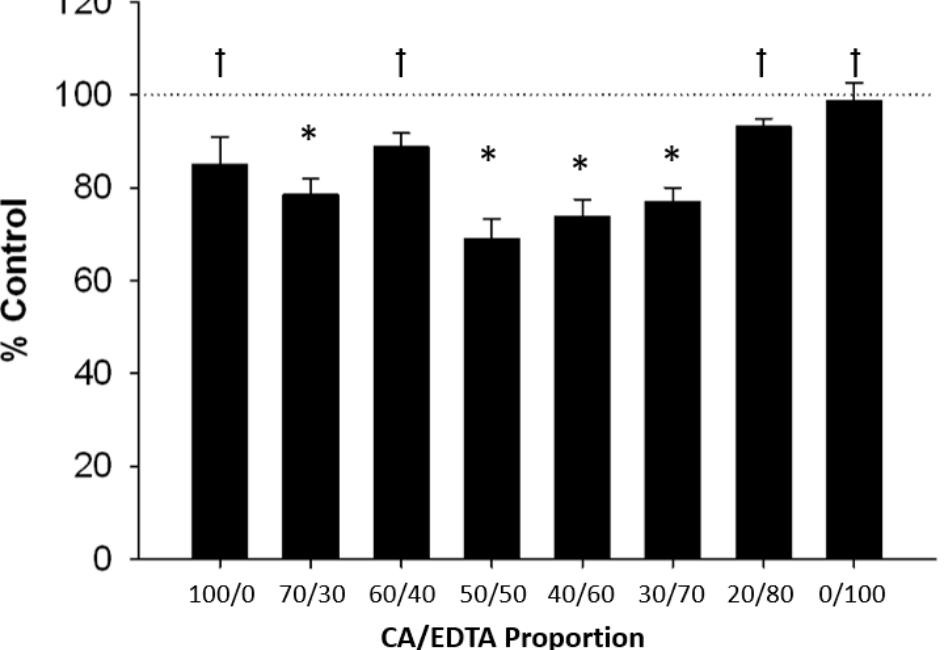
Figure 4. Neuroprotective activity of CeNPs stabilized with various ratios of citric acid and EDTA. Values represent the percent SYTOX fluorescence intensity compared to vehicle-treated control slices (mean ± SEM). Values less than 100% (control; dashed line) indicate reduced cell death. Statistical significance was determined by paired Student’s t-test comparing each CeNP treatment slice with a paired vehicle-treated control slice (* p < 0.001 compared to paired vehicle-control slice) and by a one-way ANOVA with Dunnett’s post-hoc test comparing the di ff erent ratios CA / EDTA to the 50 / 50 CA / EDTA ( † p < 0.001 compared to 50 / 50 CA / EDTA). N = 121 pairs of slices.